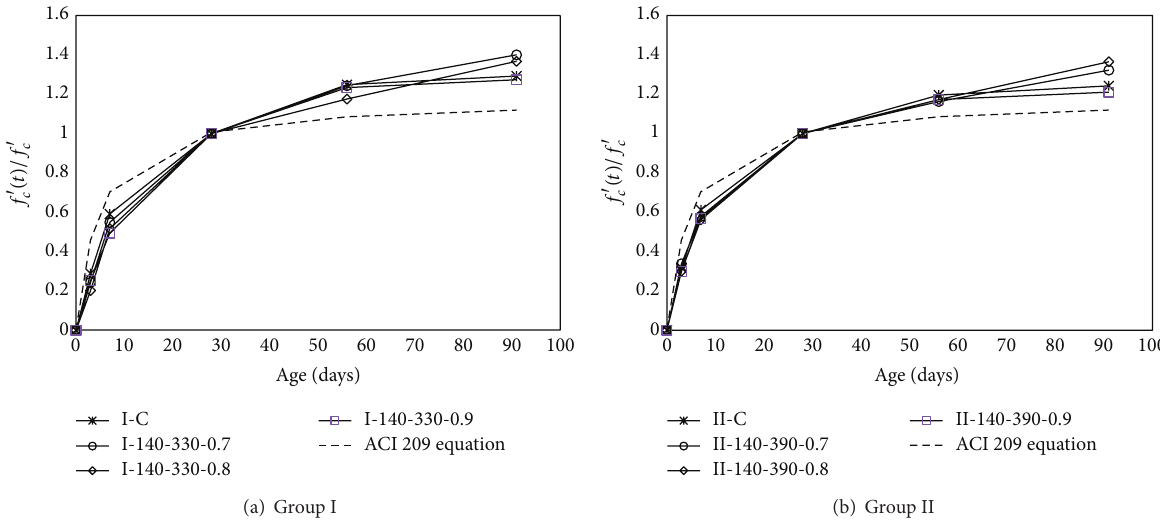
Figure 5: Typical compressive strength development rate of high-volume SCM concrete.